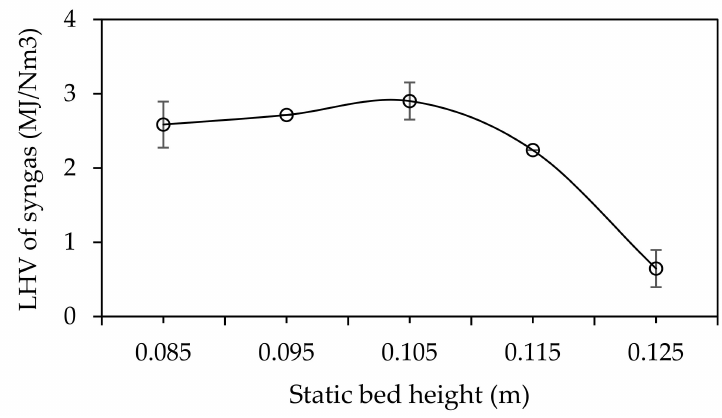
Figure 9. The e ff ect of SBH on syngas lower heating value